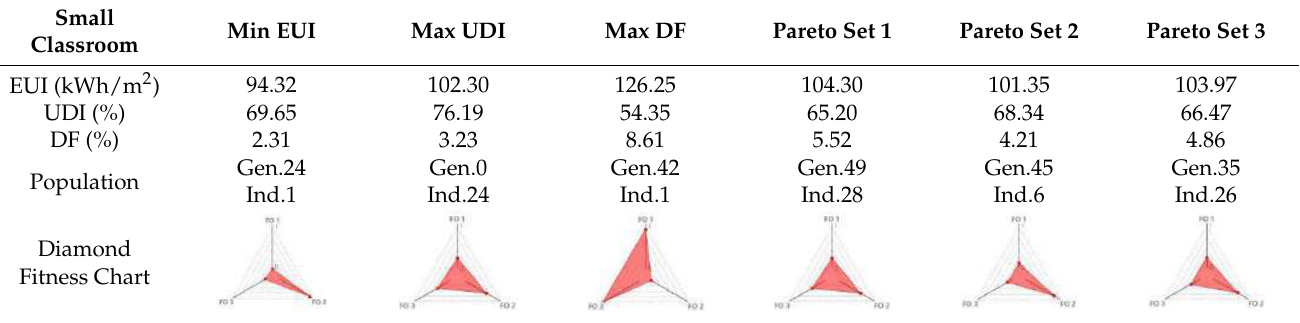
Table 7. The case of small-sized classrooms with window openings on the west facade.